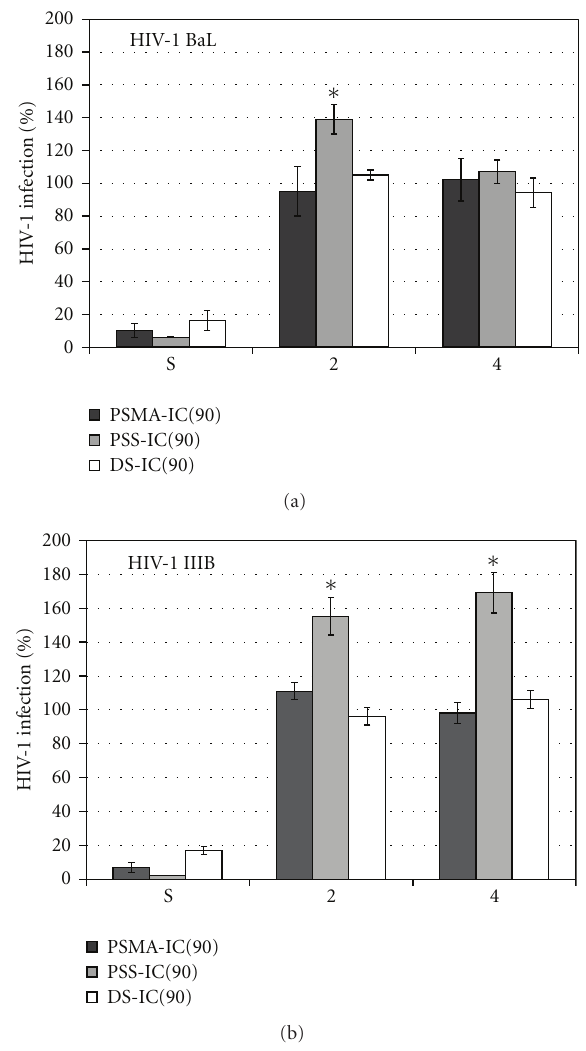
Figure 6: alt- PSMA washout does not increase HIV-1 BaL or IIIB infection. P4-R5 MAGI cells were incubated for 1 h with predetermined IC 90 concentrations of alt- PSMA (0.03mg/mL, BaL; 0.02 mg/mL, IIIB), PSS (0.1mg/mL, BaL; 2.29 mg/mL, IIIB), or DS (0.031mg/mL, BaL; 0.0028 mg/mL, IIIB). Following exposure, cells were washed thoroughly, provided with new media for 2 h or 4 h, and subsequently infected with HIV-1 strains BaL (a) or IIIB (b) for 1h. As a control, compound, virus, and cells were simultaneously incubated for 1 h (labeled “S” on each graph). Levels of infection are expressed relative to mock-treated, HIV-1 infected cells. Each concentration was examined in triplicate in two independent assays. The asterisk ( ∗ ) indicates a significant di ff erence compared to infected, mock-exposed control cells ( P ≤ .